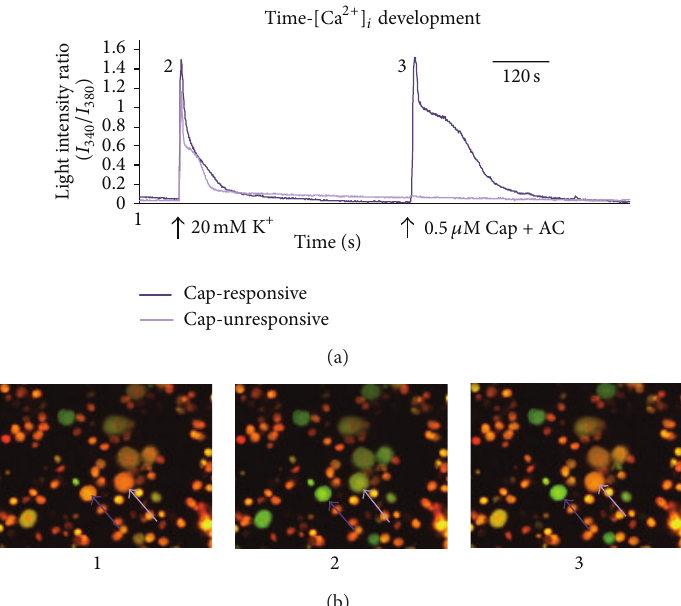
Figure 2: Example of calcium activity measurement. The figure depicts the trace of two cells obtained during a single experiment: a capsaicin- responsive (dark purple) and a capsaicin-unresponsive (light purple) neuron. The three small photomicrographs show the same neurons, at different stages of the experiment: (1) before stimulation, (2) during stimulation with 20 mM K + , and (3) during stimulation with 0.5 𝜇 M Capsaicin + algogenic chemicals. Black arrows beneath the trace indicate the beginning of stimulation. Time scale bar; 120s. Cap; capsaicin.